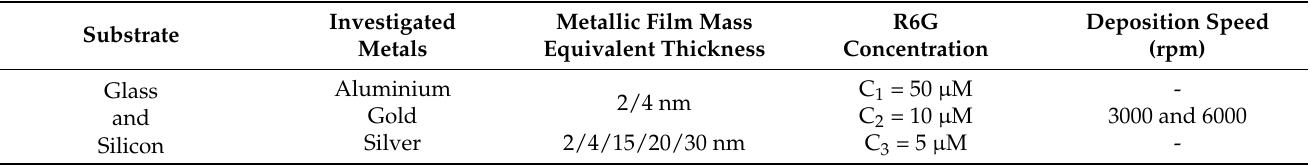
Table 2. Materials and parameters.